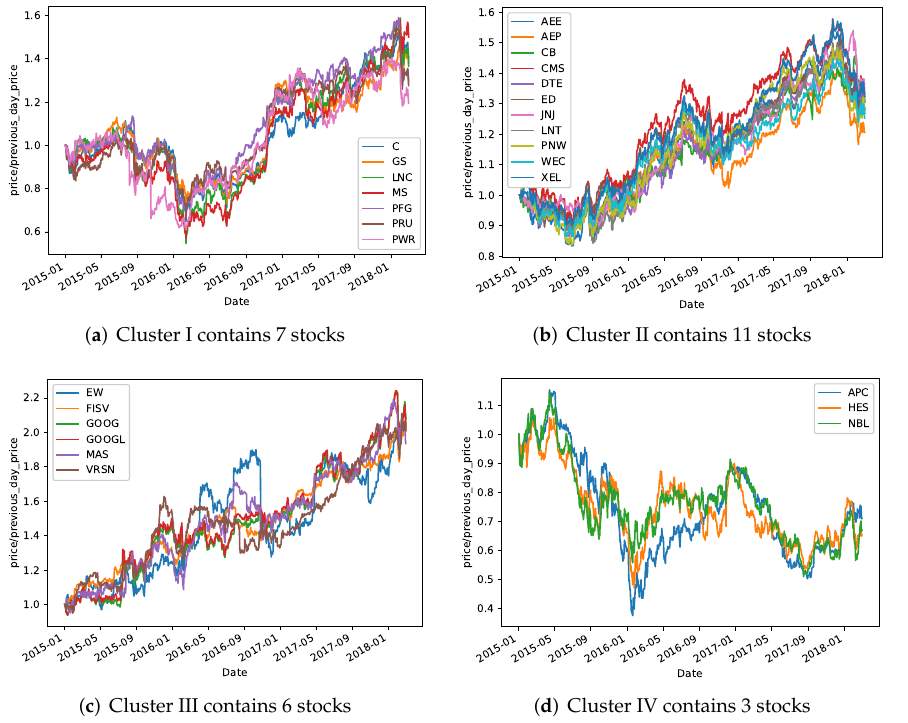
Figure 7. Randomly selected groups from S&P500 based on TCN-Deep Clustering.